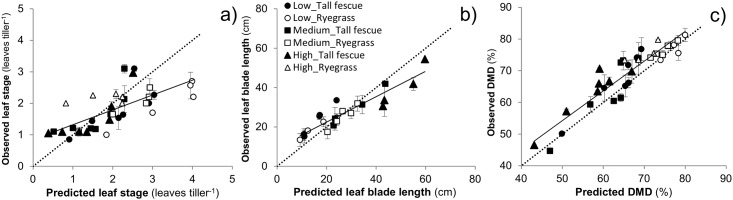
Evaluation of the MDP model.Predicted vs. observed leaf stage (a), leaf blade length (b) and digestibility of dry matter (c) of spring and summer regrowth of tall fescue- (solid symbols) and ryegrass-based (open symbols) pasture managed under three residual sward height treatments (low, ●○; medium, ■□; high, ▲Δ) in Exp.1.